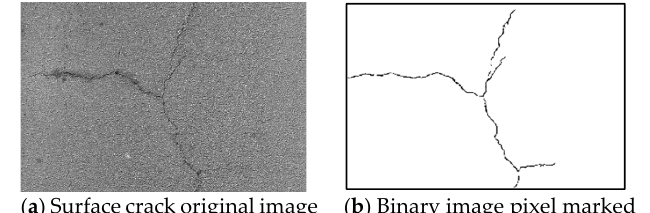
Figure 1. Two characterizations of